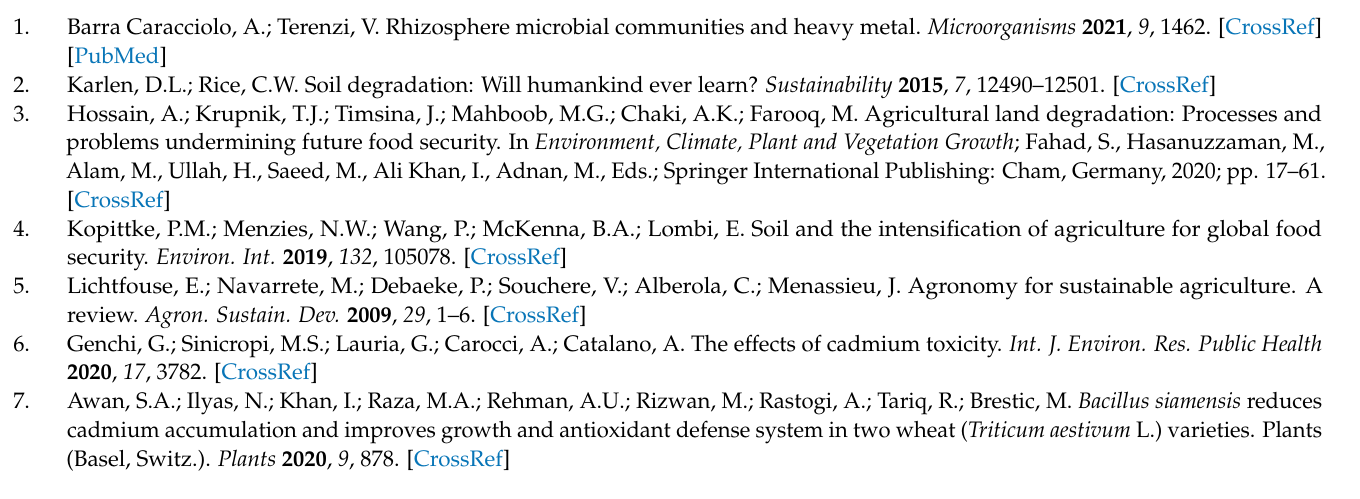
Table S3: The number of fungi, 10 7 cfu kg − 1 d.m. of soil; Table S4: Dehydrogenases